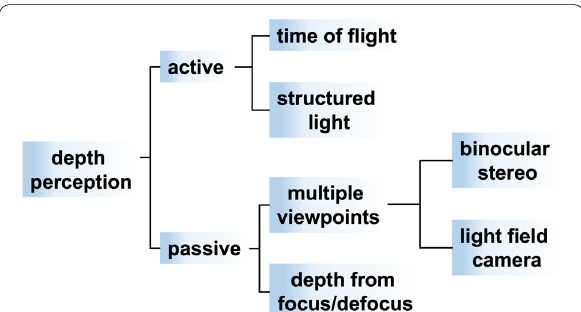
Fig. 9 Categorization of depth